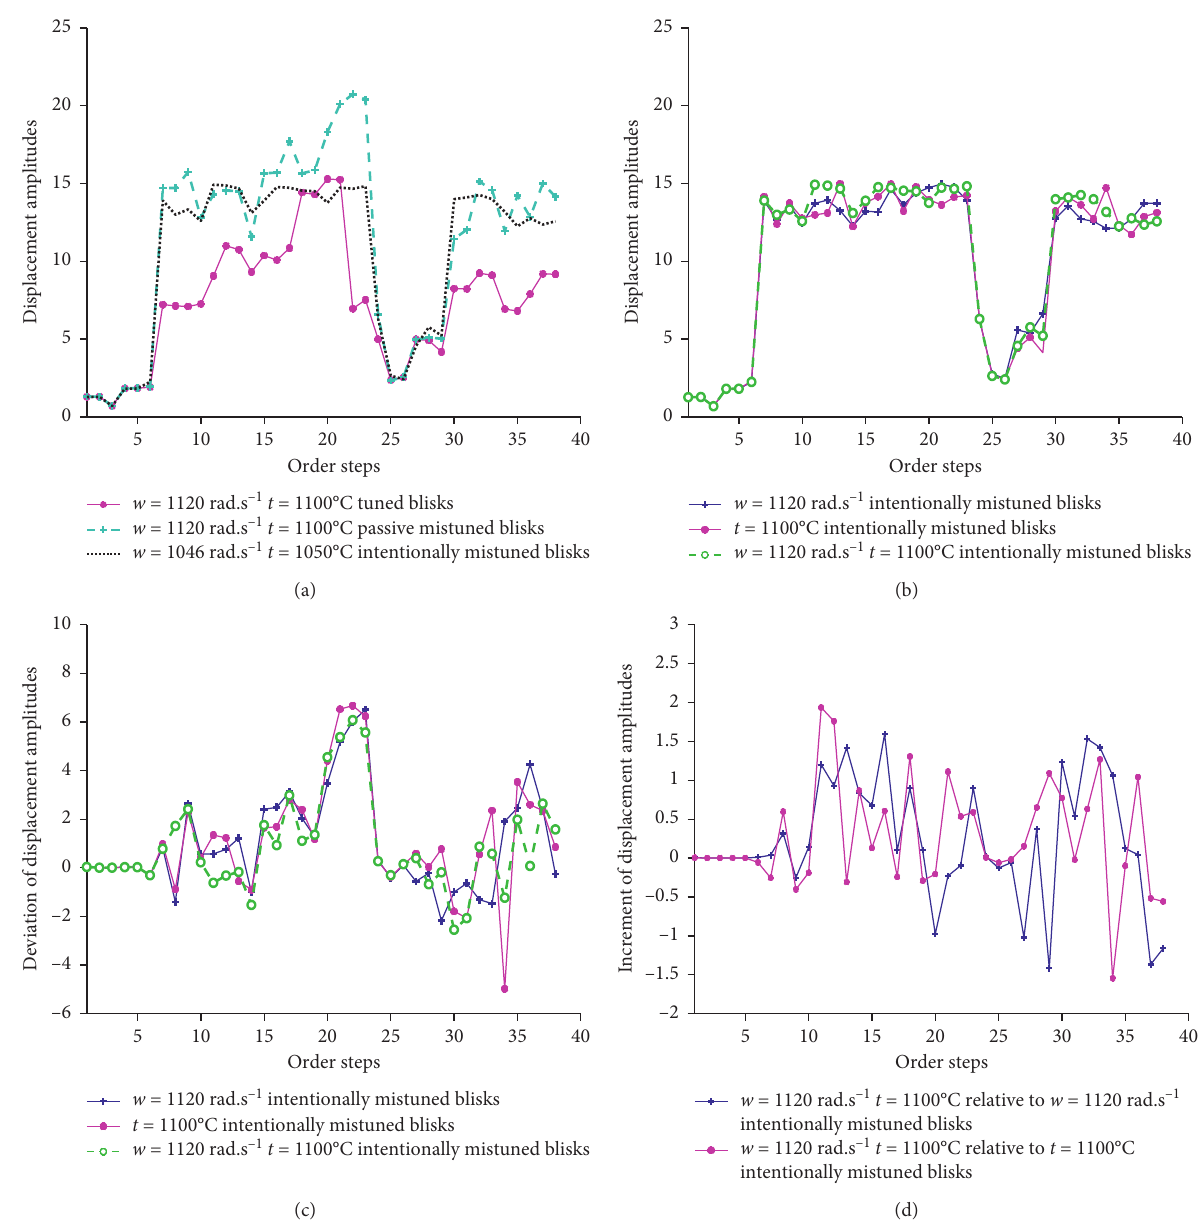
Figure 13: Displacement amplitudes of intentionally MTB. (a) DAs of tuning, passive, and intentional mistuning. (b) DAs of intentional mistuning. (c) Deviation of DAs. (d) Increment of